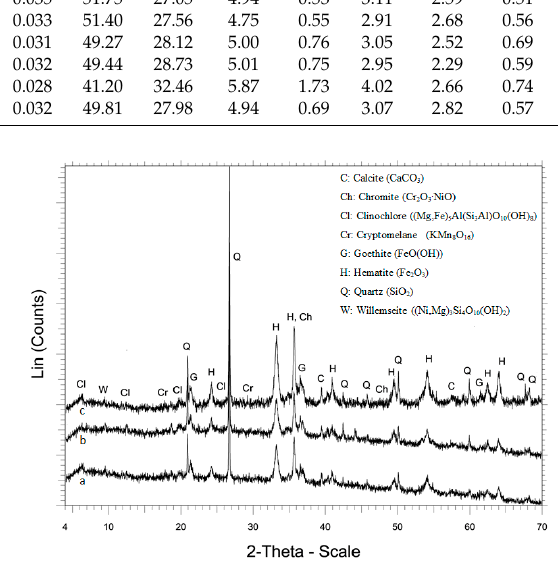
Figure 2. XRD patterns of ( a ) LAI, ( b ) residue after leaching with 1.5 M H 2 SO 4 , and ( c ) residue after leaching with 1.5 M H 2 SO 4 and 20 g/L Na 2 SO 3 .